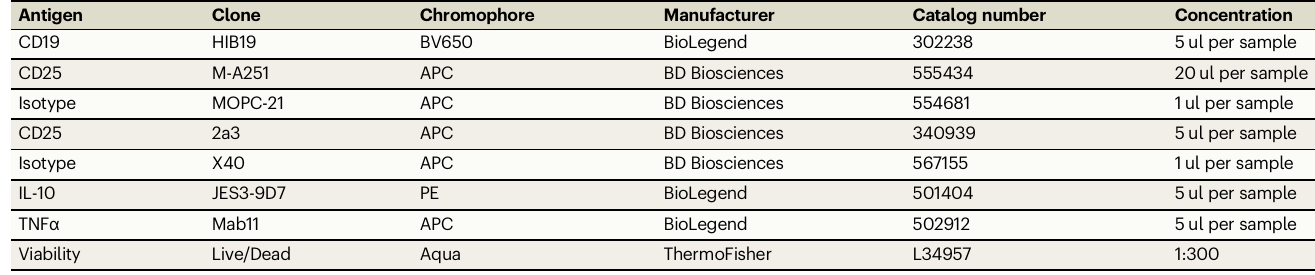
Table 1 | Human antibodies used in fl ow cytometry experiments